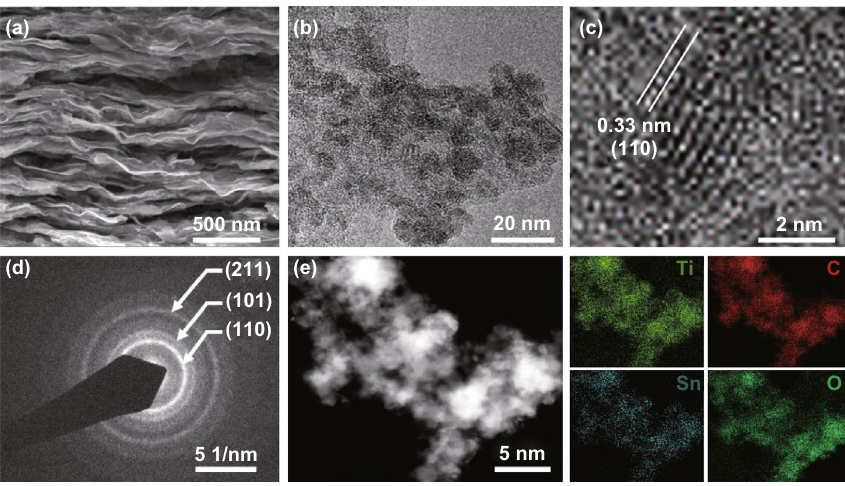
Fig. 1 Schematic illustration for the preparation of 0D–2D SnO 2 QDs/MXene hybrids